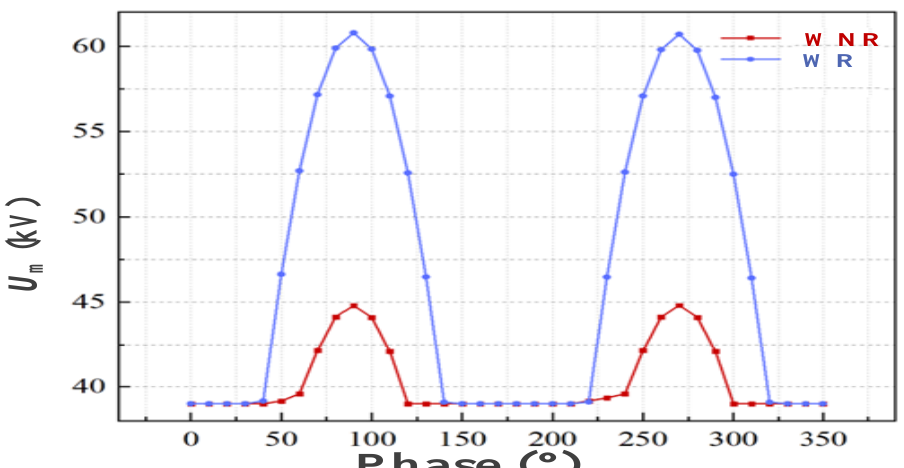
Figure 9. Influence of residual magnetism on overvoltage ( WR is “with residual magnetization”, WNR is “without residual magnetization” ).